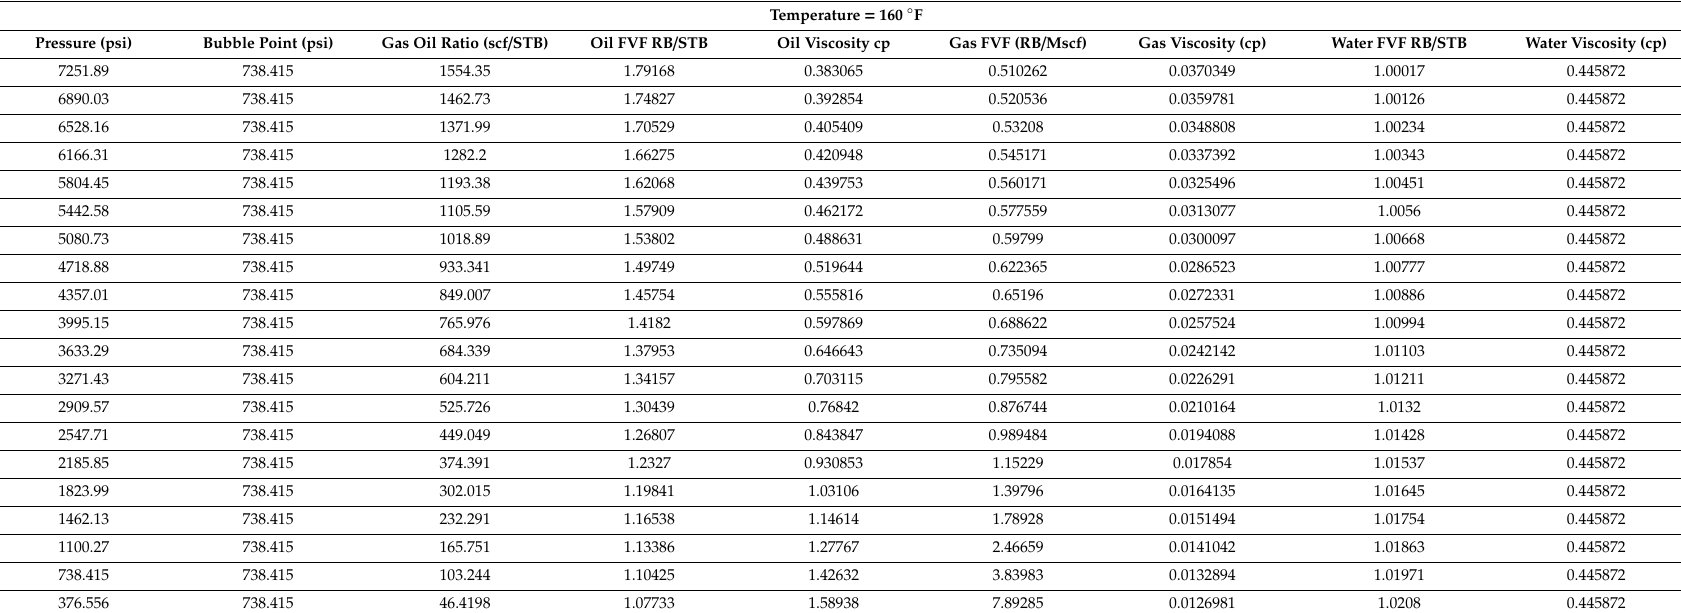
Table A3. PVT properties at 160 ◦